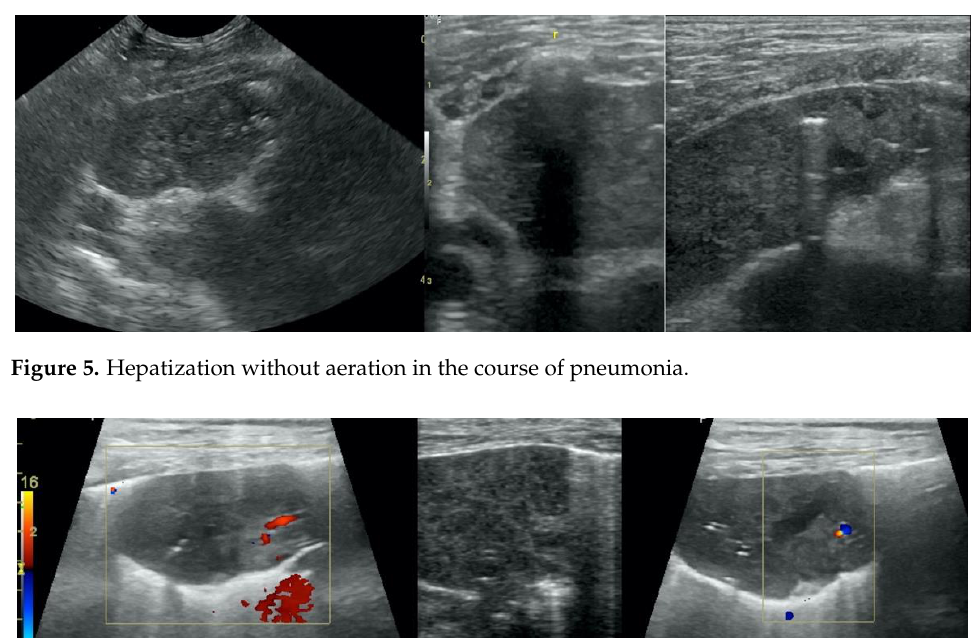
Figure 4. Subpleural consolidations in the course of lung cancer.